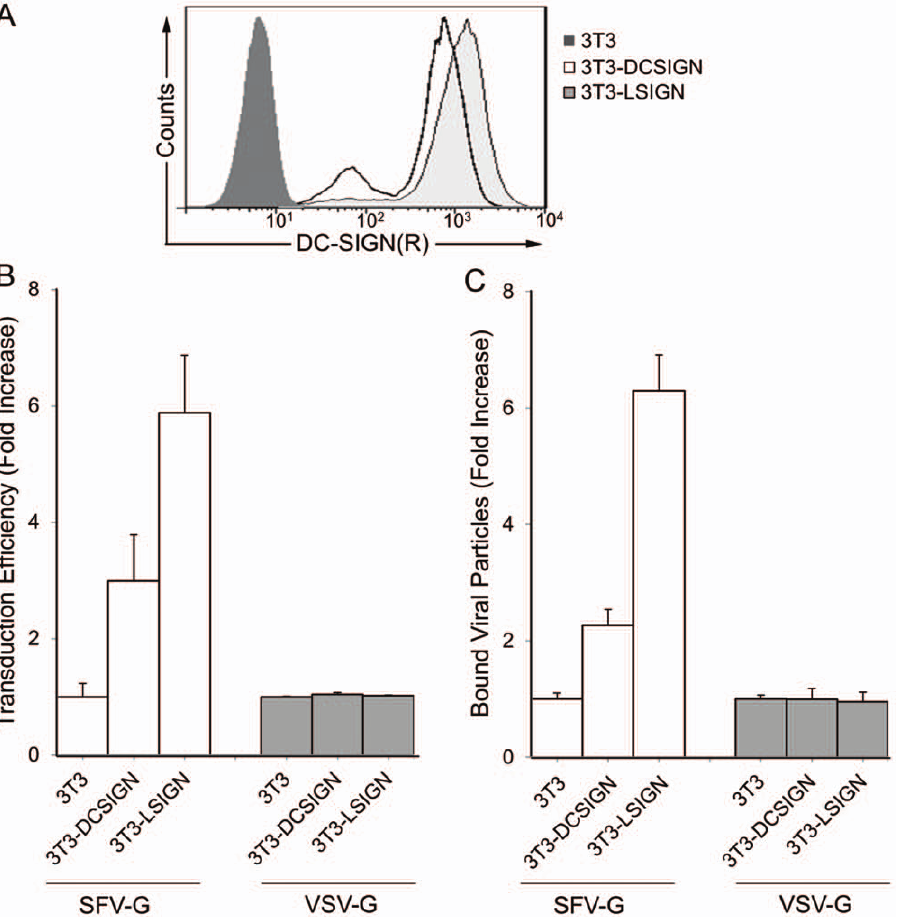
Figure 3. Effects of DC-SIGN or L-SIGN expression. (A) Expression of L-SIGN and DC-SIGN in 3T3 (solid fill), 3T3.DCSIGN (open fill) and 3T3.LSIGN (gray fill), respectively, was detected using cross reactive DC-SIGN/L-SIGN antibody and quantified by flow cytometry. (B) Effects of DC-SIGN or L-SIGN expression on the infectivity of pseudotyped lentiviruses. SFV-G- and VSV-G-pseudotyped lentiviruses were normalized by p24 and spin-inoculated with LSIGN- or DCSIGN-expressing 3T3 cells; the parental 3T3 cells were included as controls. Three days later, the transduction efficiency was measured by analyzing GFP expression. Fold increase in percentage of GFP-positive cells is shown based on 3T3 cells where FUGW/SFVG transduced 6.6 6 0.7% and FUGW/VSVG transduced 72.2 6 1.0%. (C) Specificity of binding to DC-SIGN. [ 35 S]-methionine-labeled FUGW/SFVG or FUGW/VSVG were incubated with 3T3 or DC-SIGN/L-SIGN-expressing cells at 4 u C. Cells were washed and 35 S radioactivity of the resuspended cells was quantitated with a liquid scintillation counter. Fold increase in [ 35 S] bound viral particles is shown based on 3T3 cells with 3.59 6 0.27% and 25.23 6 1.25% of the total CPM of virus bound for FUGW/SFVG and FUGW/VSVG, respectively, where values are given as the mean of triplicates 6 S.E.